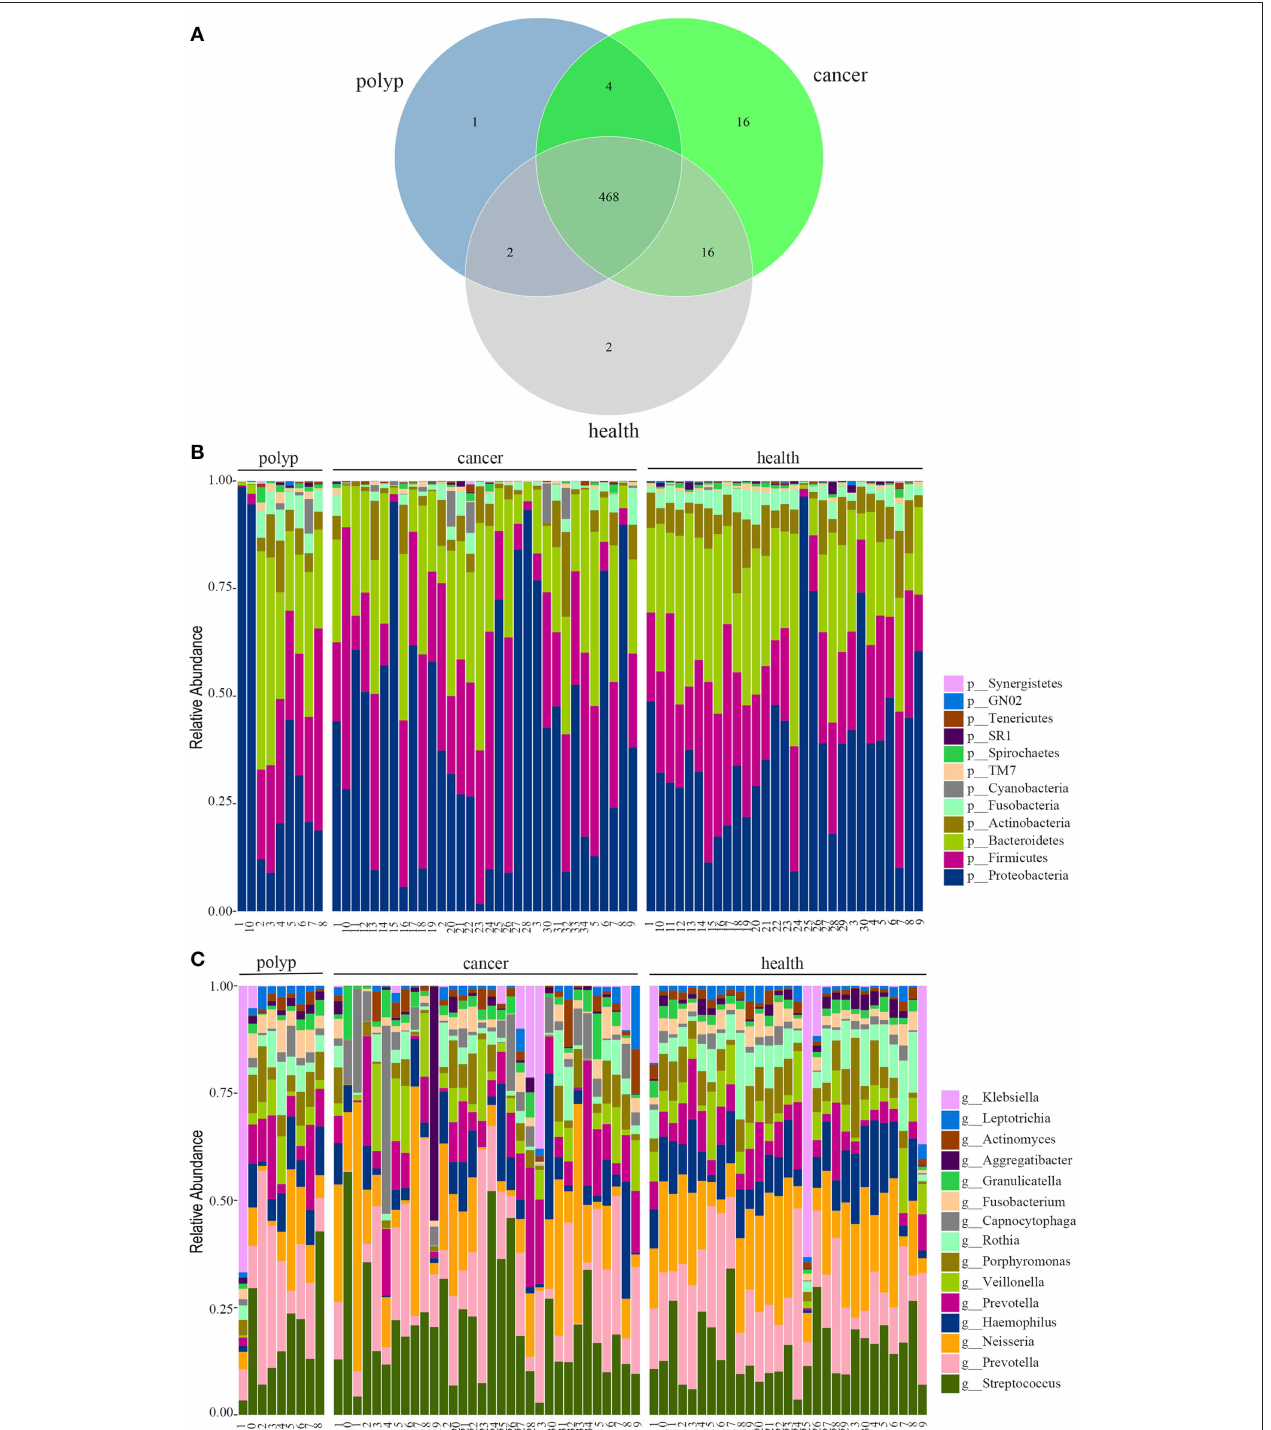
FIGURE 1 | The oral microbiota profiles of samples from throat cancer patients, vocal cord polyp patients, and healthy individuals. (A) A Venn diagram comparing the operational taxonomic unit (OTU) distribution among the throat cancer, vocal cord polyp, and normal control groups. (B) The relative abundance of the dominant phyla in the throat cancer, vocal cord polyp, and normal control groups. (C) The relative abundance of the dominant genera in the throat cancer, vocal cord polyp, and normal control groups.